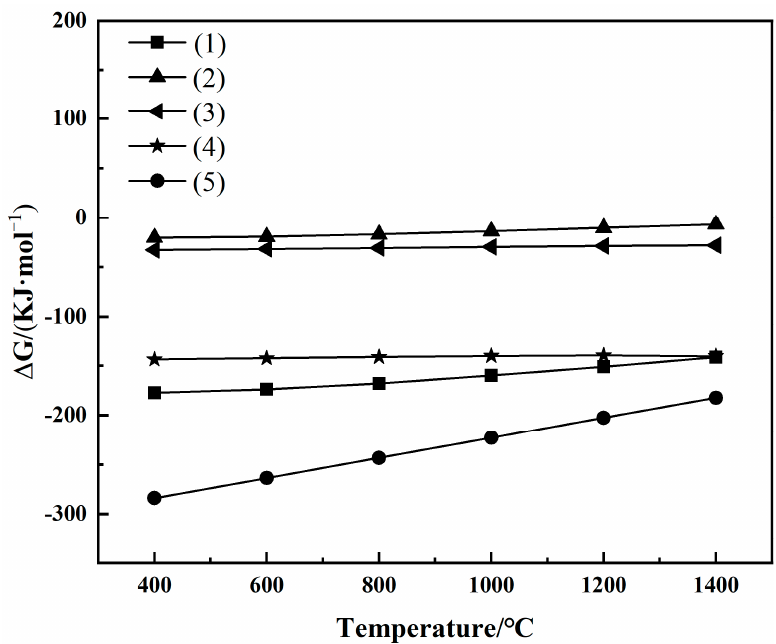
Figure 5. Correlation between the standard Gibbs free energy ( Δ G θ ) and temperature for reactions (1) – (5) in Table 3.